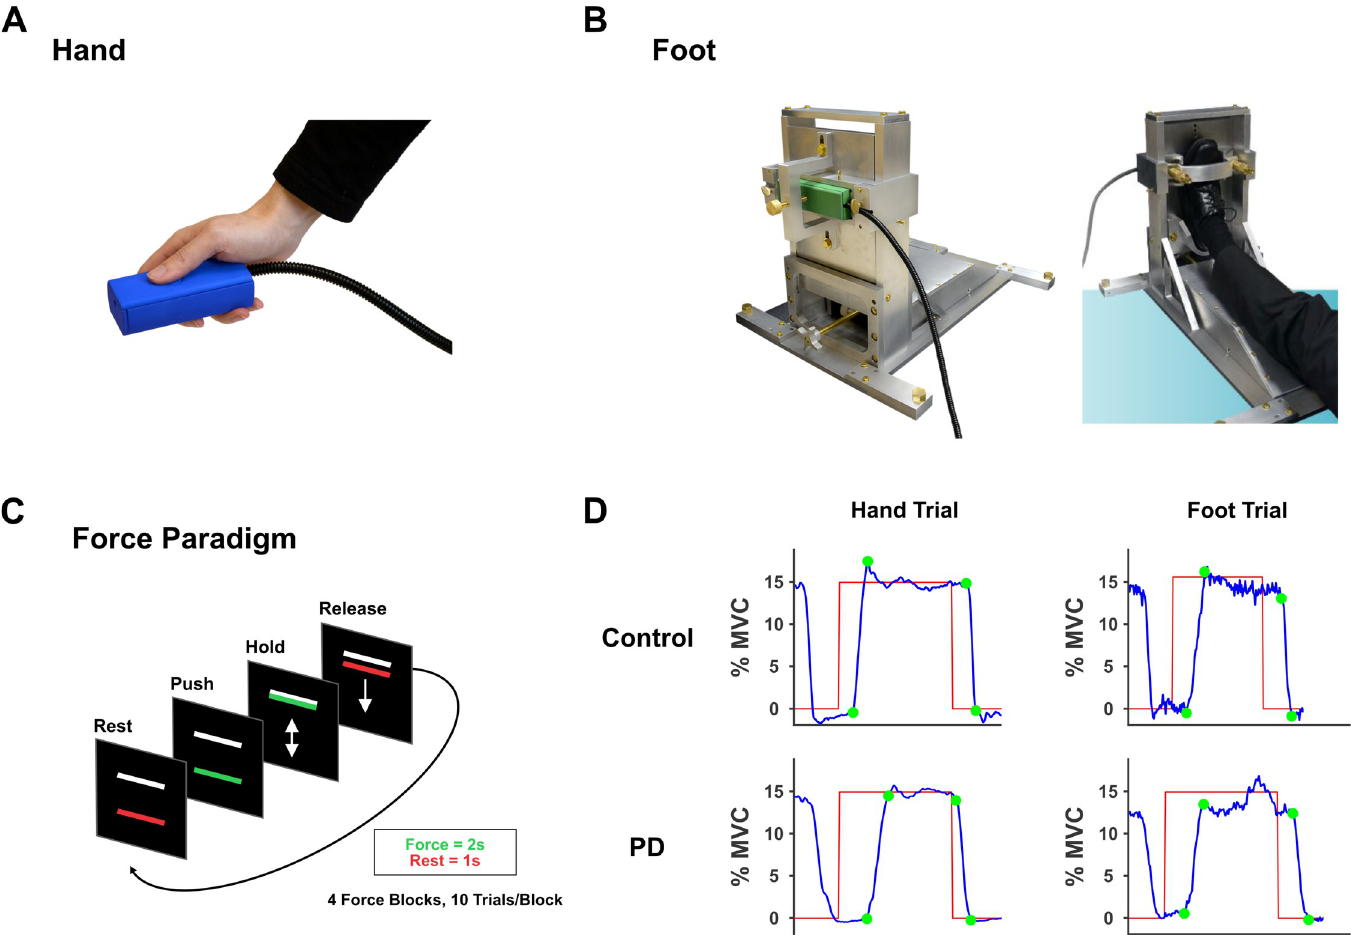
Fig 1. Experimental setup and paradigm. (A) Hand force device that measured pinch force. (B) Custom-designed foot device that measured the force produced by dorsiflexing the ankle. (C) Depiction of the force paradigm. After a 30s rest period, the red force bar turned green to cue force generation. The participants had to produce force for 2s and relax for 1s (1 trial = 3s, 10 trials per block/cycle). Instructions were to produce force as quick as possible and match the white target bar. When the bar turned red again, the participants rested for 1s. There were 4 30-s blocks of force production, and each force block was followed by a 30-s resting period. (D) Sample force data illustrating a trial per task for one representative control and one PD. For each force trial, four points were defined: ( p1 ) onset of force, ( p2 ) onset of the steady period during which the amplitude of the force bar matched the amplitude of the target bar, ( p3 ) offset of the steady period, and ( p4 ) offset of force.